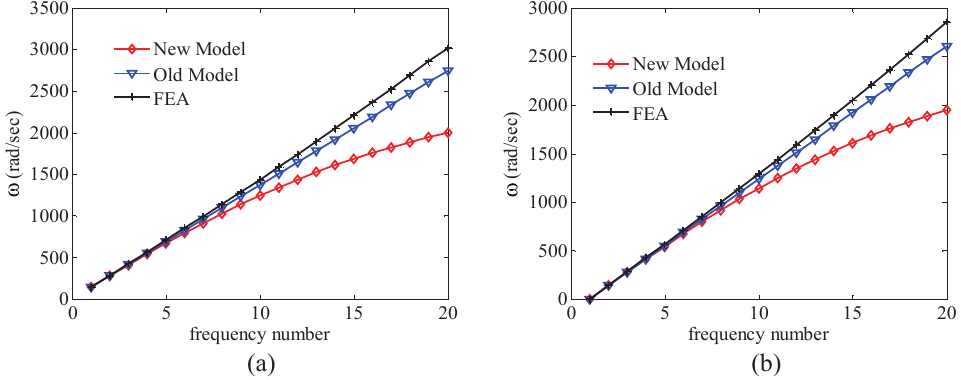
Fig. 4. Longitudinal natural frequencies for a 120 m lattice structure for a) clamped-clamped b) free-free boundary